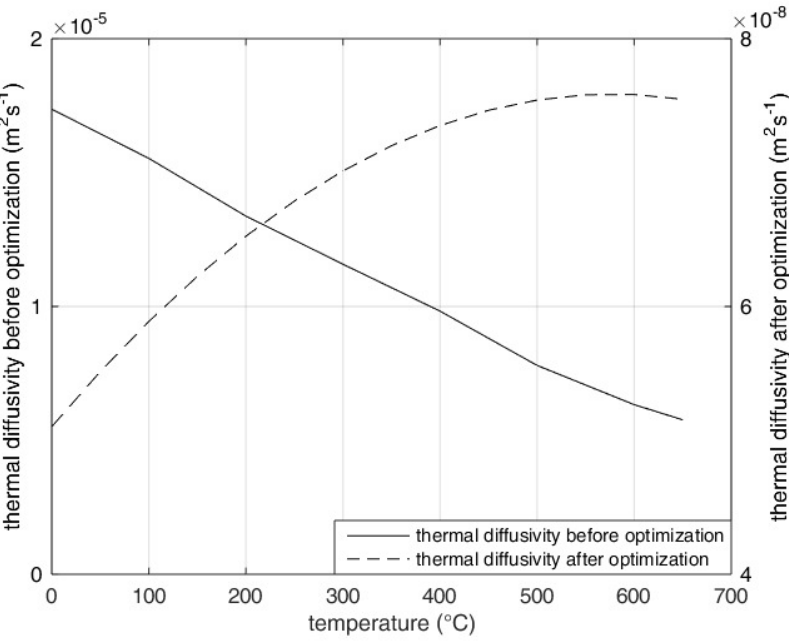
Figure 10. Thermal diffusivity behavior before and after